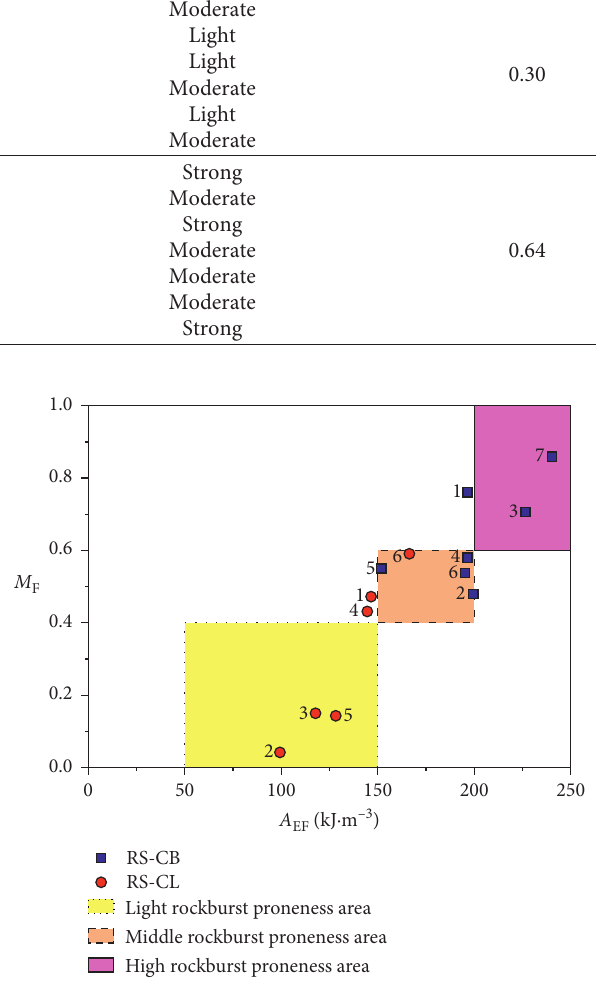
Figure 11: Matching relationship between the residual elastic energy index and far-field ejection mass ratio.